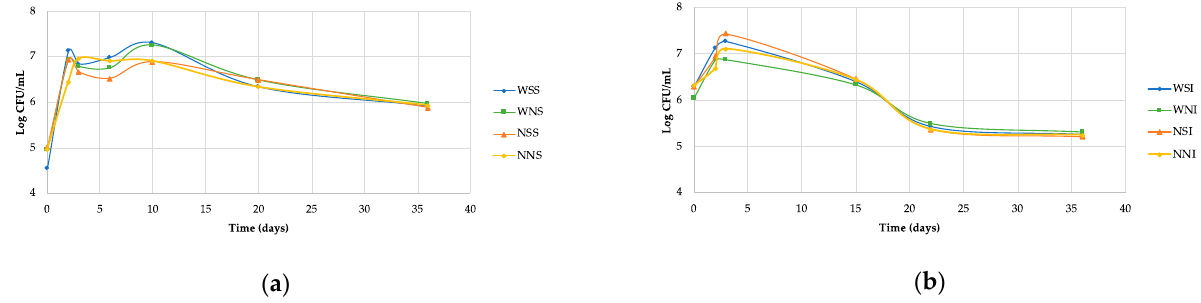
Figure 4. Total yeast population during spontaneous ( a ) and inoculated ( b ) microvinification trials of Figure 2 (WSS and WSI), washed grapes without SO 2 (WNS and WNI), non-washed grapes with SO 2 (NSS and NSI), non-washed grapes without SO 2 (NNS and NNI).